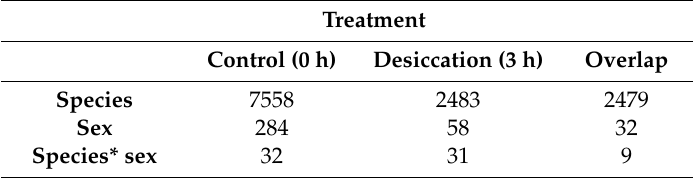
Table 1. Number of genes found to be significantly DE for each term of the ANOVA, analyzed separately for each treatment. ‘Overlap’ indicates number of genes that were found to be significantly DE in both